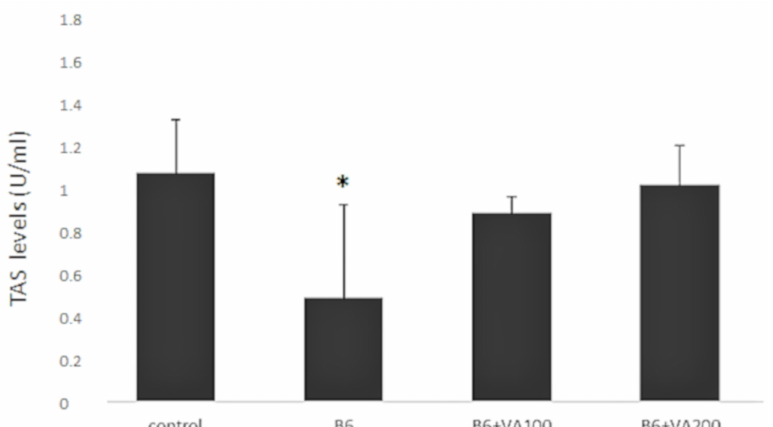
Figure 3. The effects of benomyl and benomyl accompanied by two concentrations of VA (100 and 200 µ M) on the total antioxidant status (TAS) levels of the cells. B6: exposure to 6 µ M benomyl; VA100: exposure to 100 µ M valerenic acid; VA200: exposure to 200 µ M valerenic acid (* statistically significant difference compared to the